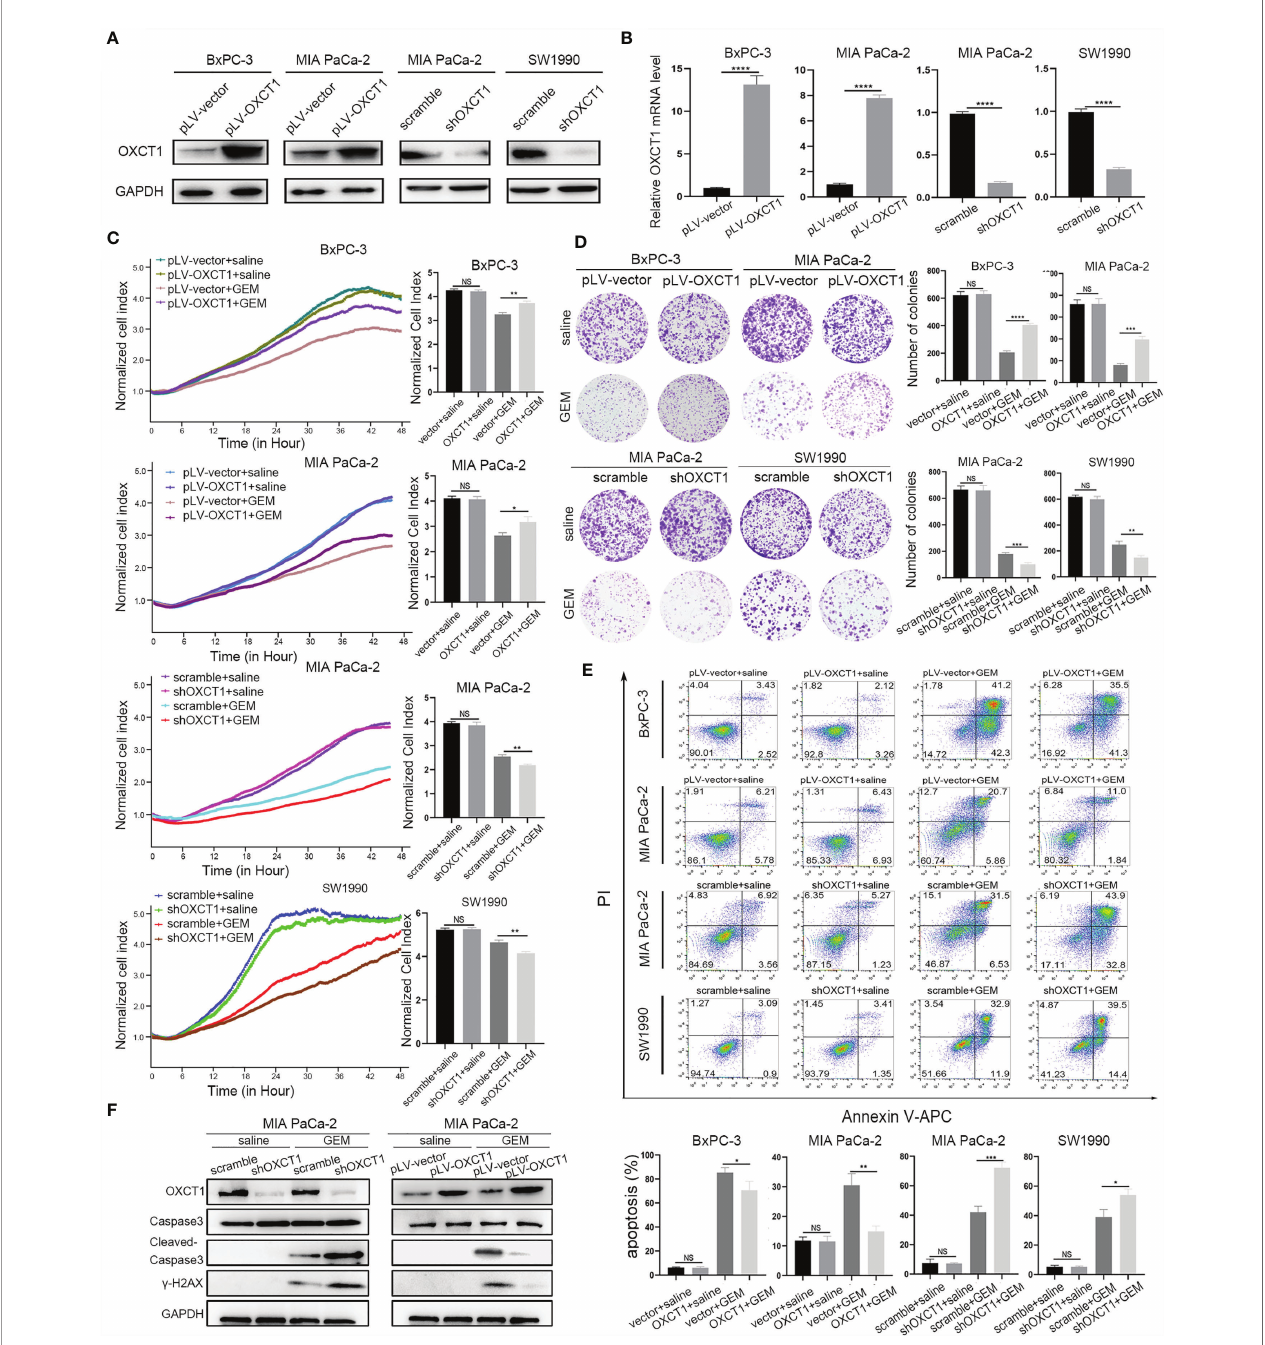
FIGURE 3 | Effect of OXCT1 on GEM resistance in PDAC cells. (A) Western blot analysis of proteins extracted from the two OXCT1-overexpressing stable cell lines (BxPC-3 and MIA PaCa-2) and two OXCT1-knockdown cell lines (MIA PaCa-2 and SW1990). (B) Real − time quantitative PCR analysis of OXCT1 expression levels in PDAC stable cell line included in (A) . (C) OXCT1-overexpressing stable cell lines (BxPC-3 and MIA PaCa-2) and OXCT1-knockdown cell lines (MIA PaCa-2 and SW1990) were treated with either 50 nM GEM or saline before conducting the cytotoxicity assay. Real-time cell index measurements (xCELLigence) of the live target cells cultured with GEM or saline are shown in (C) . The corresponding 72 h normalized cell index is shown as the histogram . (D) Representative images and quanti fi cation using the colony formation assay of the indicated cell lines that were treated for 72 h with GEM or saline. (E) Flow cytometry was performed to measure the apoptosis rates of the indicated cell lines treated with 50 nM GEM or saline for 72 h The corresponding statistics are presented in the histogram. (F) Detection of cleaved-caspas3 and g -H2AX in OXCT1 overexpression and knockdown MIA PaCa-2 cell lines. The data are expressed as mean ± SEM from three independent experiments. * P < 0.05; ** P < 0.01; *** P < 0.001; **** P < 0.0001 (one-way ANOVA). NS, not signi fi